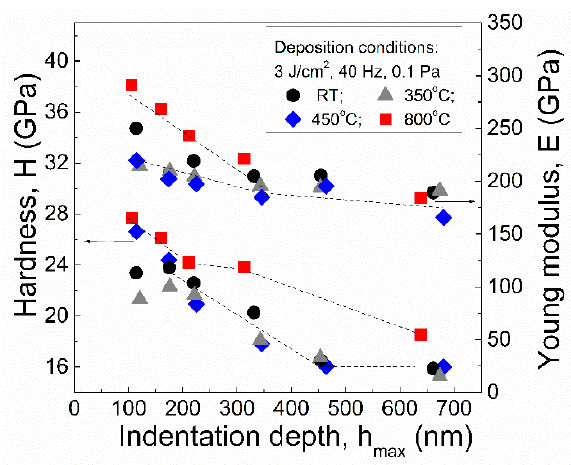
Figure 2. Nanohardness H and elastic modulus E as a function of the maximum nominal penetration depth, h max , of the PLD AlN films obtained using the deposition conditions given in the inset.